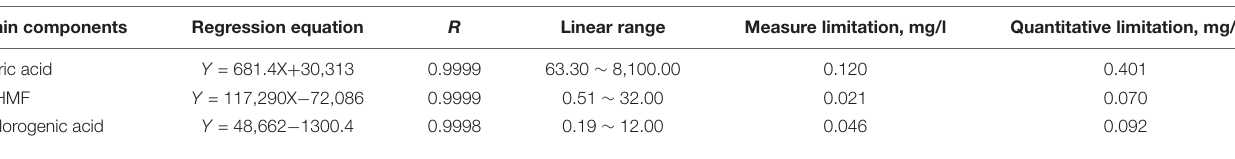
TABLE 1 | Linear relationships of major components of